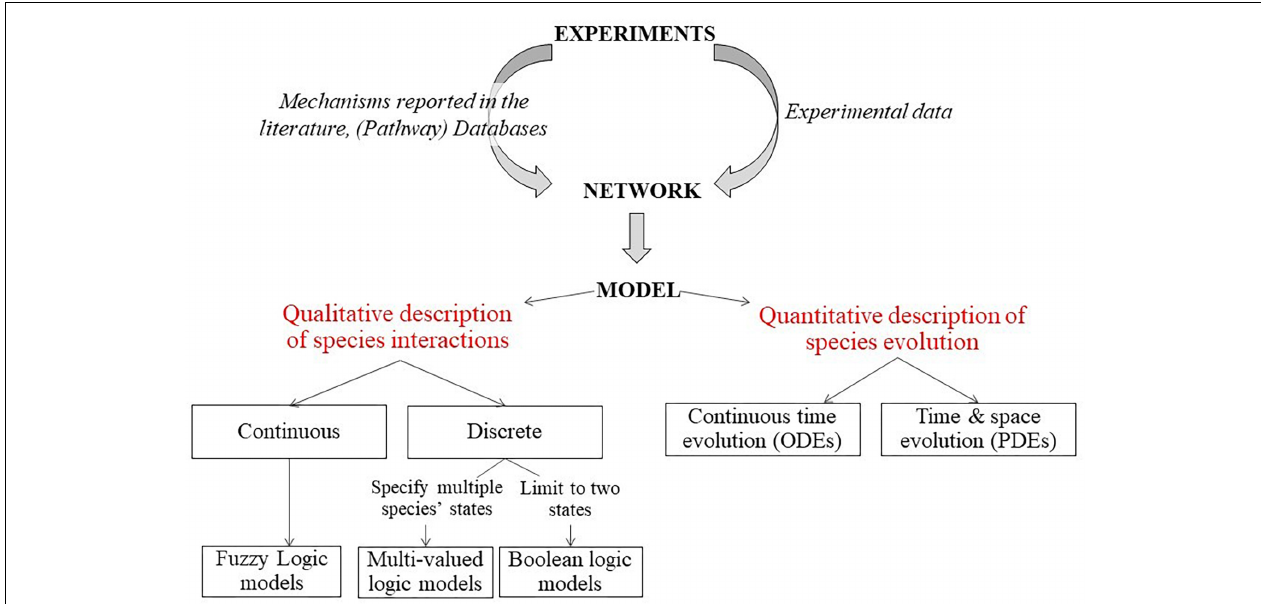
FIGURE 5 | Description of modeling framework for regulatory networks. Firstly, a static network graph is generated from experimental data and mechanisms reported in literature. Then, various modeling approaches can be used to simulate the temporal evolution of the components of the network. Quantitative models use ODE to describe the temporal evolution of species (cell density etc.) and can also include spatial resolution by using partial differential equations. Qualitative models on the other hand use logical statements to describe the evolution of species (Lesage et al.,